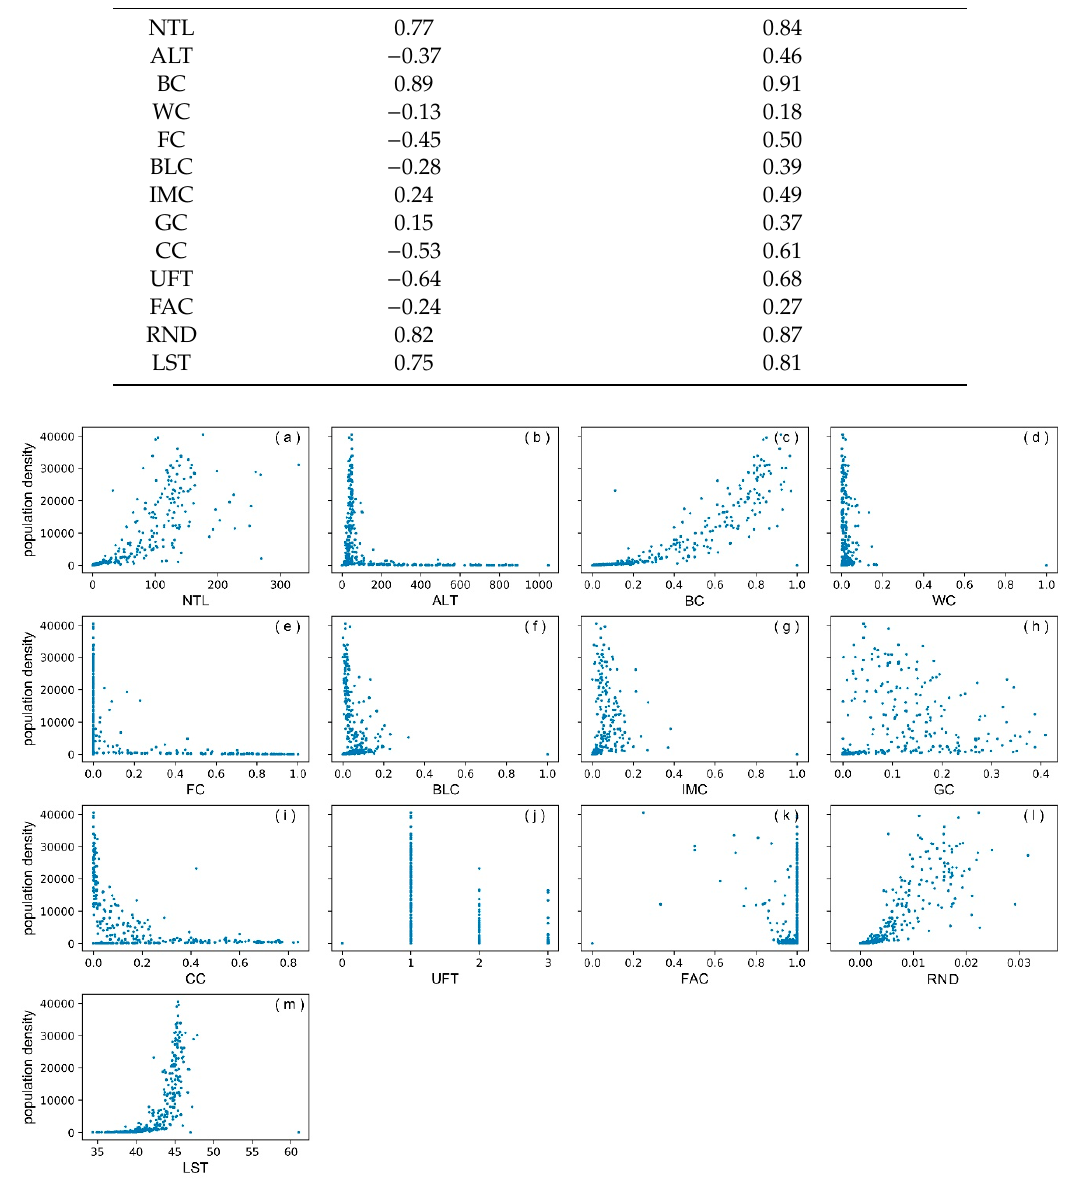
Figure 6. Scatterplot of township population density and 13 independent variables ( a – m ).